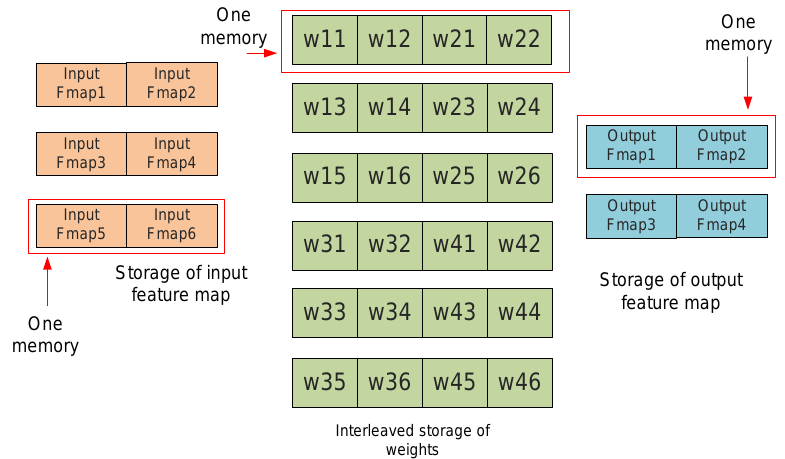
Figure 7. Data storage